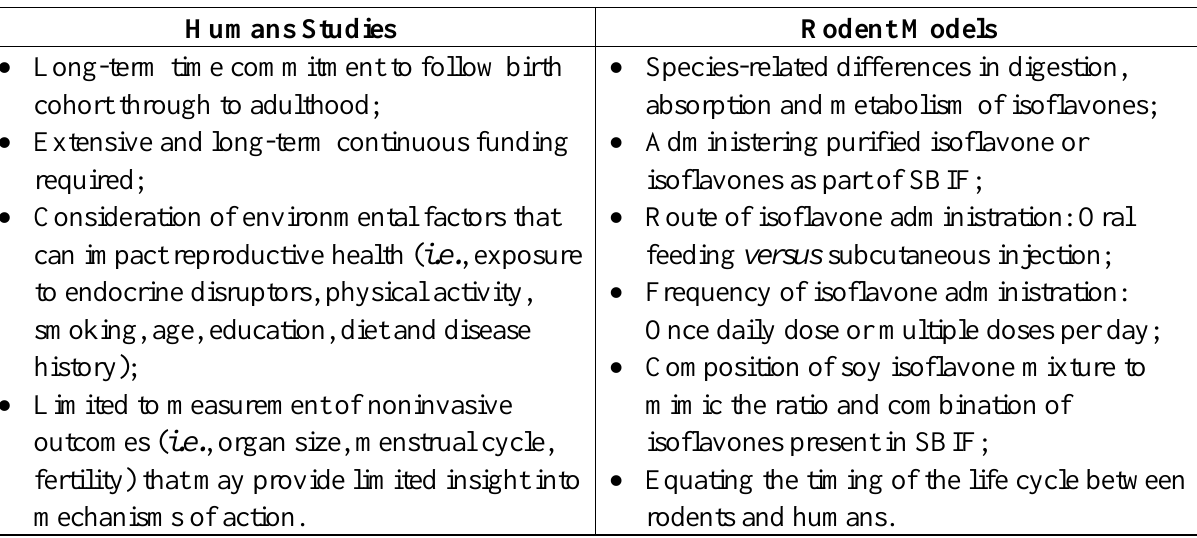
Table 1. The challenges of designing and conducting studies in humans or using rodent models to study the effects of soy isoflavones on reproductive